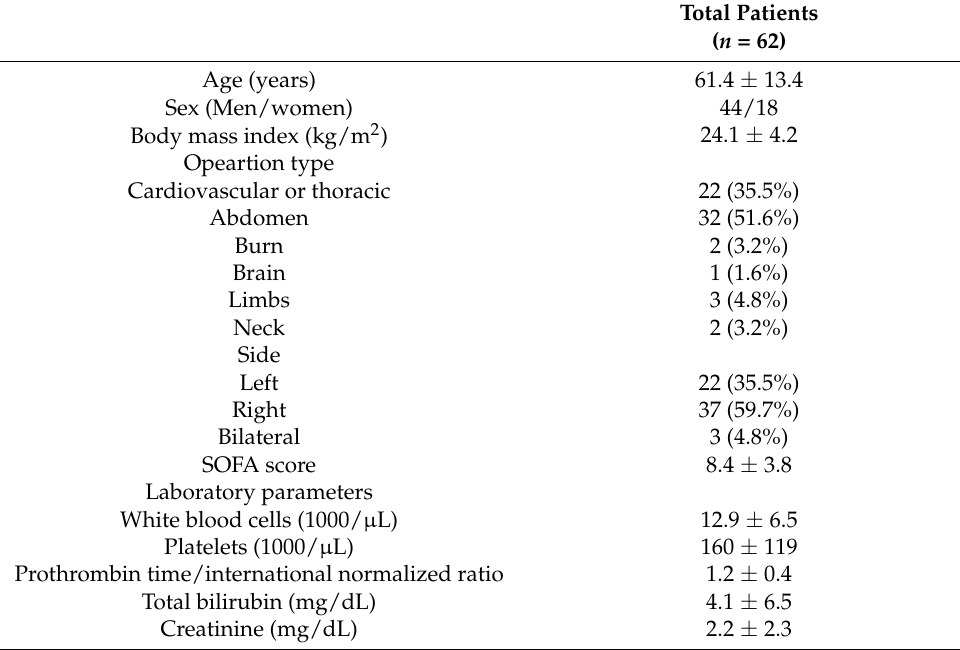
Figure 1. Flow of patients through the study. Table 1. General characteristics of the study patients.